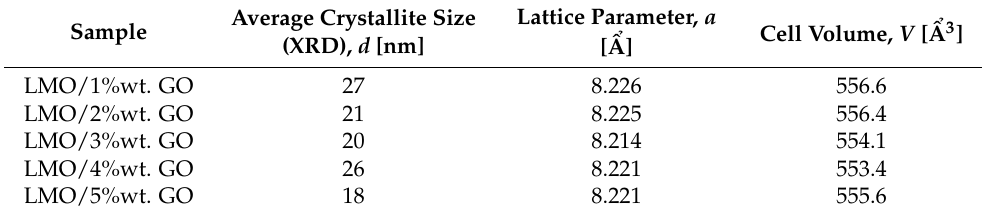
Table 2. The band assignment of spectra of LMO/1–5%wt. GO. Raman